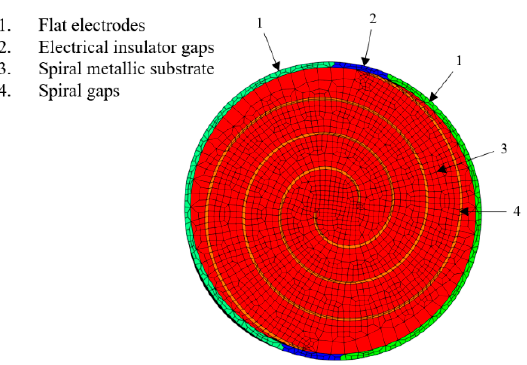
Figure 11. Structural parts of electrically heated catalyst model.